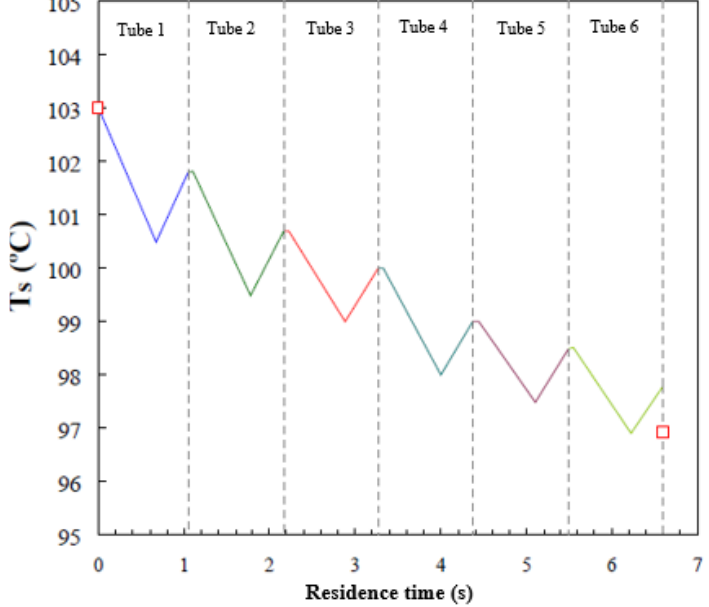
Figure 7. Average temperature profile of the solution film versus residence time. The solution temperature profile inside the falling-film absorber on horizontal